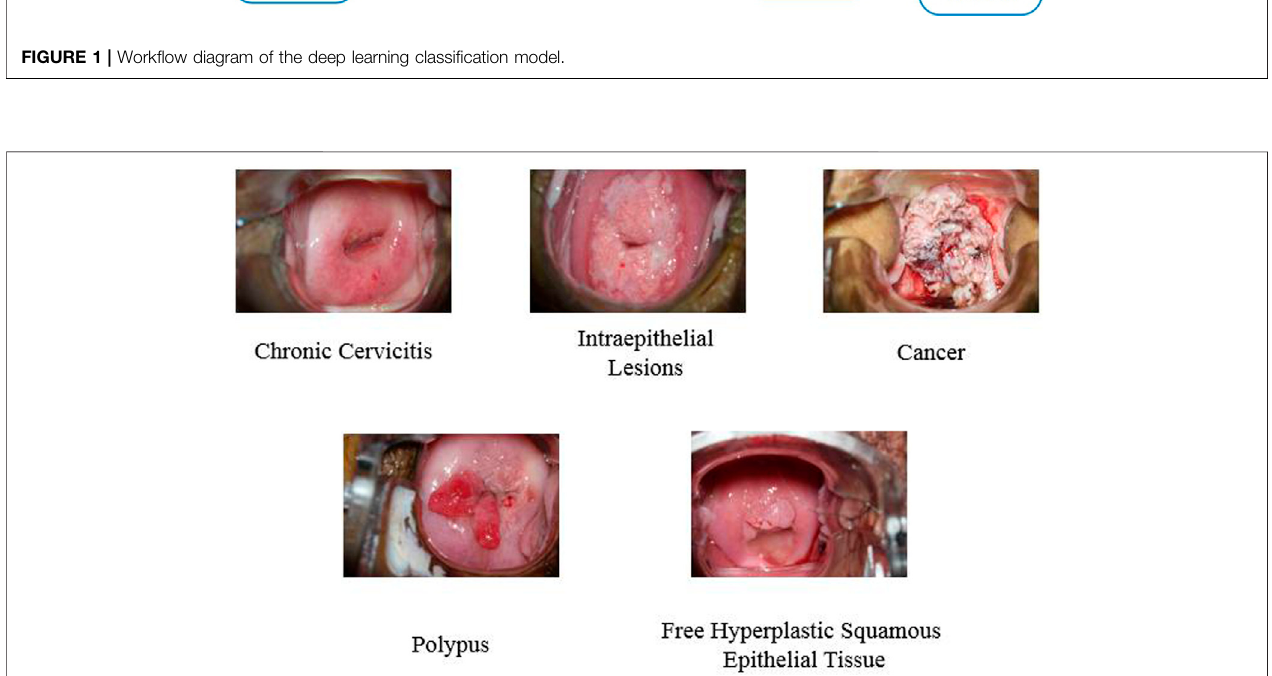
FIGURE 2 | Sample image of different